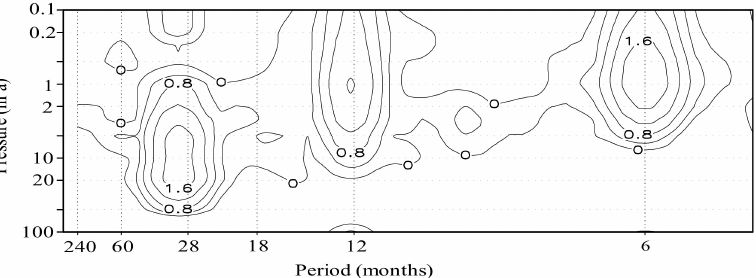
Figure 2. Power spectrum of zonal–mean-zonal wind from 100 to 0.1 hPa averaged between 10 ◦ S and 10 ◦ N. Values are displayed in a logarithmic scale of base 10 and units are in m 2 s − 2 . The contour interval is 0.4 m 2 s − 2 .